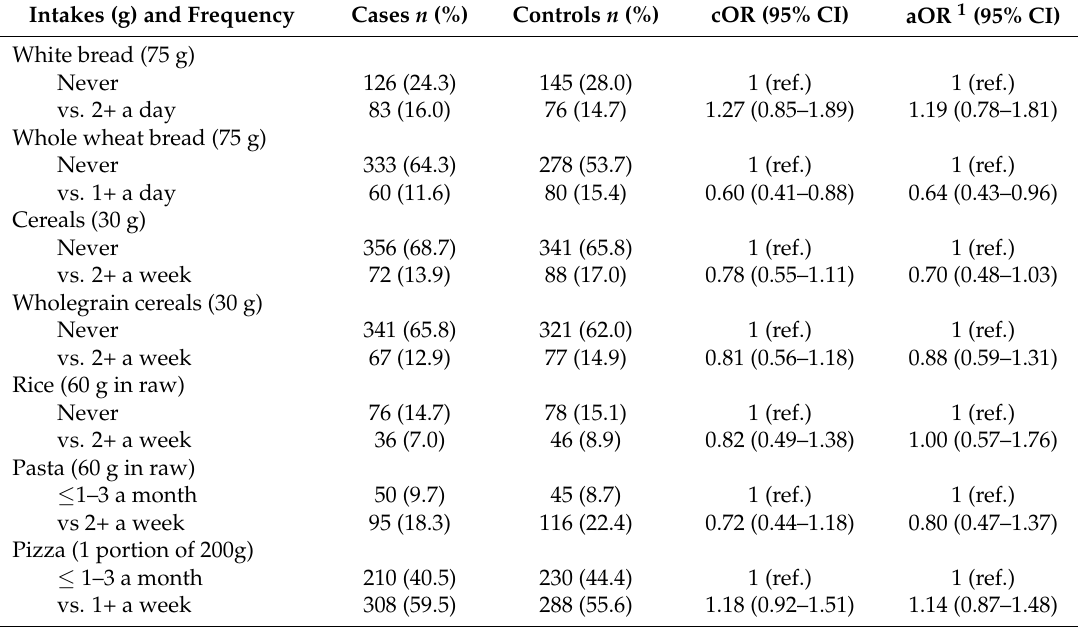
Table 2. Frequency of intake of different types of bread and cereals and risk of